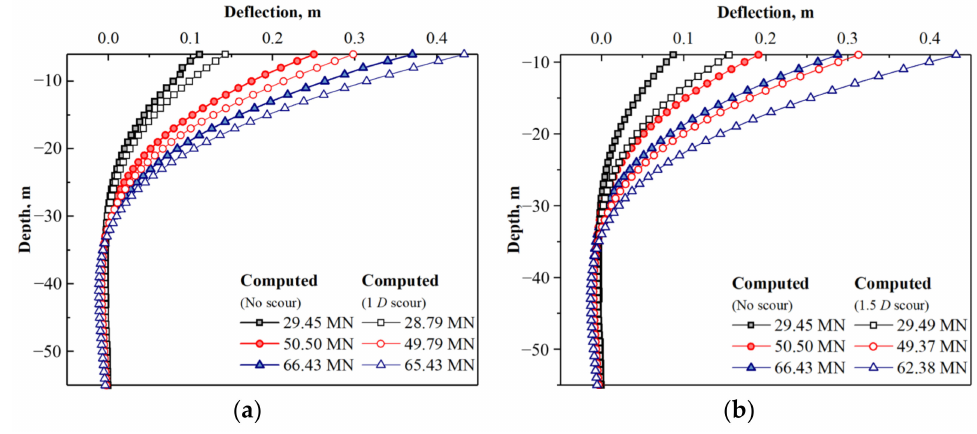
Figure 4. Comparison of pile deflection before and after scouring; ( a ) S d 1 = 1 D ( 6 m ) ; ( b ) S d 2 = 1.5 D ( 9 m ) .